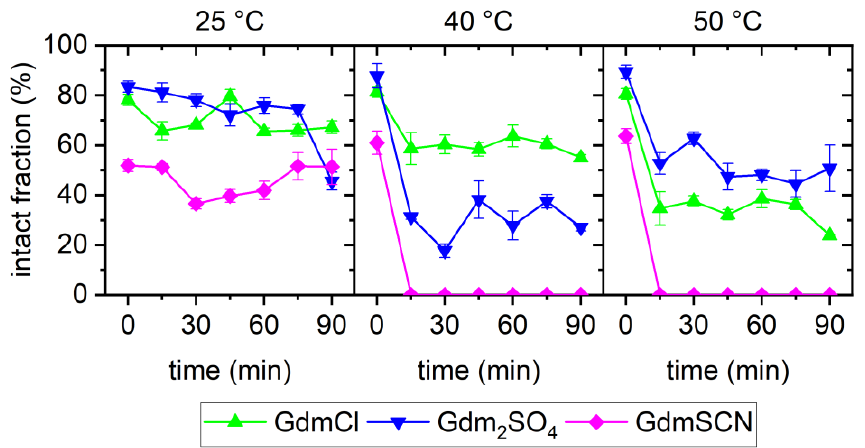
Figure 7. Comparison of the fractions of intact DNA origami triangles obtained in the different Gdm salts at different temperatures and as a function of incubation time. salts at different temperatures and as a function of incubation